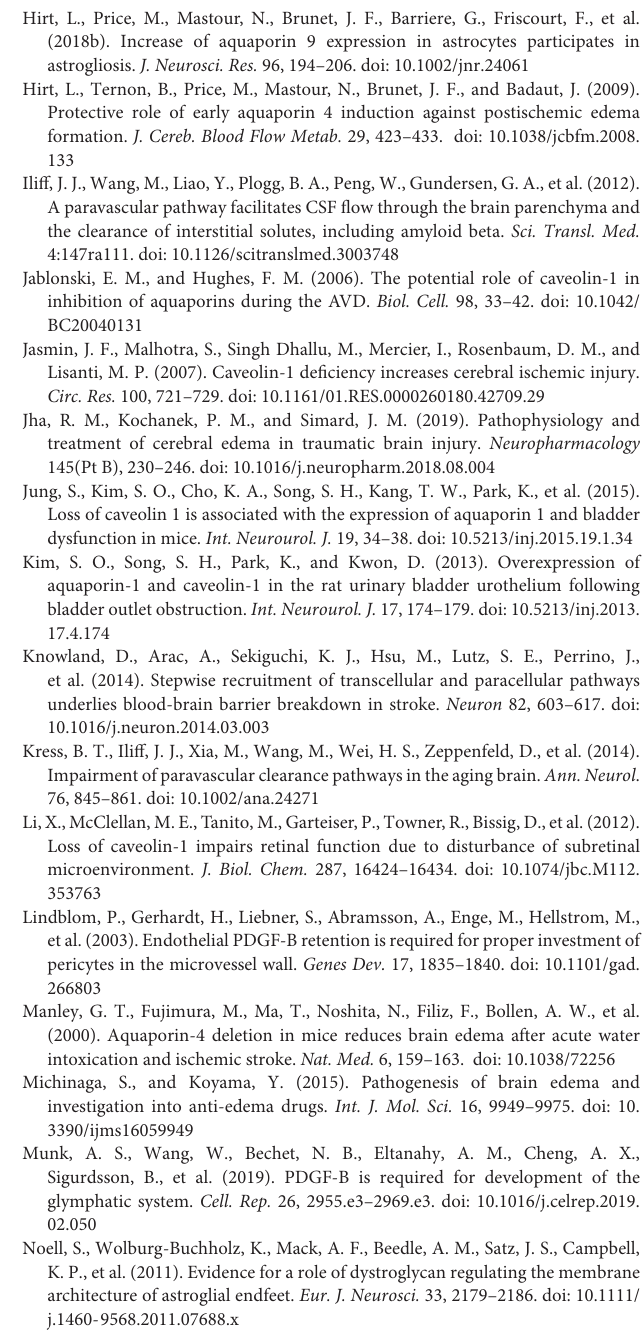
FIGURE S1 | (A) Coronal brain sections at 72 h after sham and MCAO injury showing the different regions of interest (ROIs) for on high magnification images and respective quantifications. (B) Analysis of cortical astrocytic morphology on GS- and GFAP-immunolabeled images and by skeletonization; n = 3 areas per animal with 3 animals per group. The data are shown as median and interquartile range; only significant differences are displayed. FIGURE S2 | (A) Immunofluorescence staining with AQP4 (green) and Glutamine Synthetase (GS) (gray) in WT and Cav-1 KO mice at 72 h post-MCAO ( × 63 magnification). AQP4 co-localized with GS-positive astrocyte end-feet. Scale